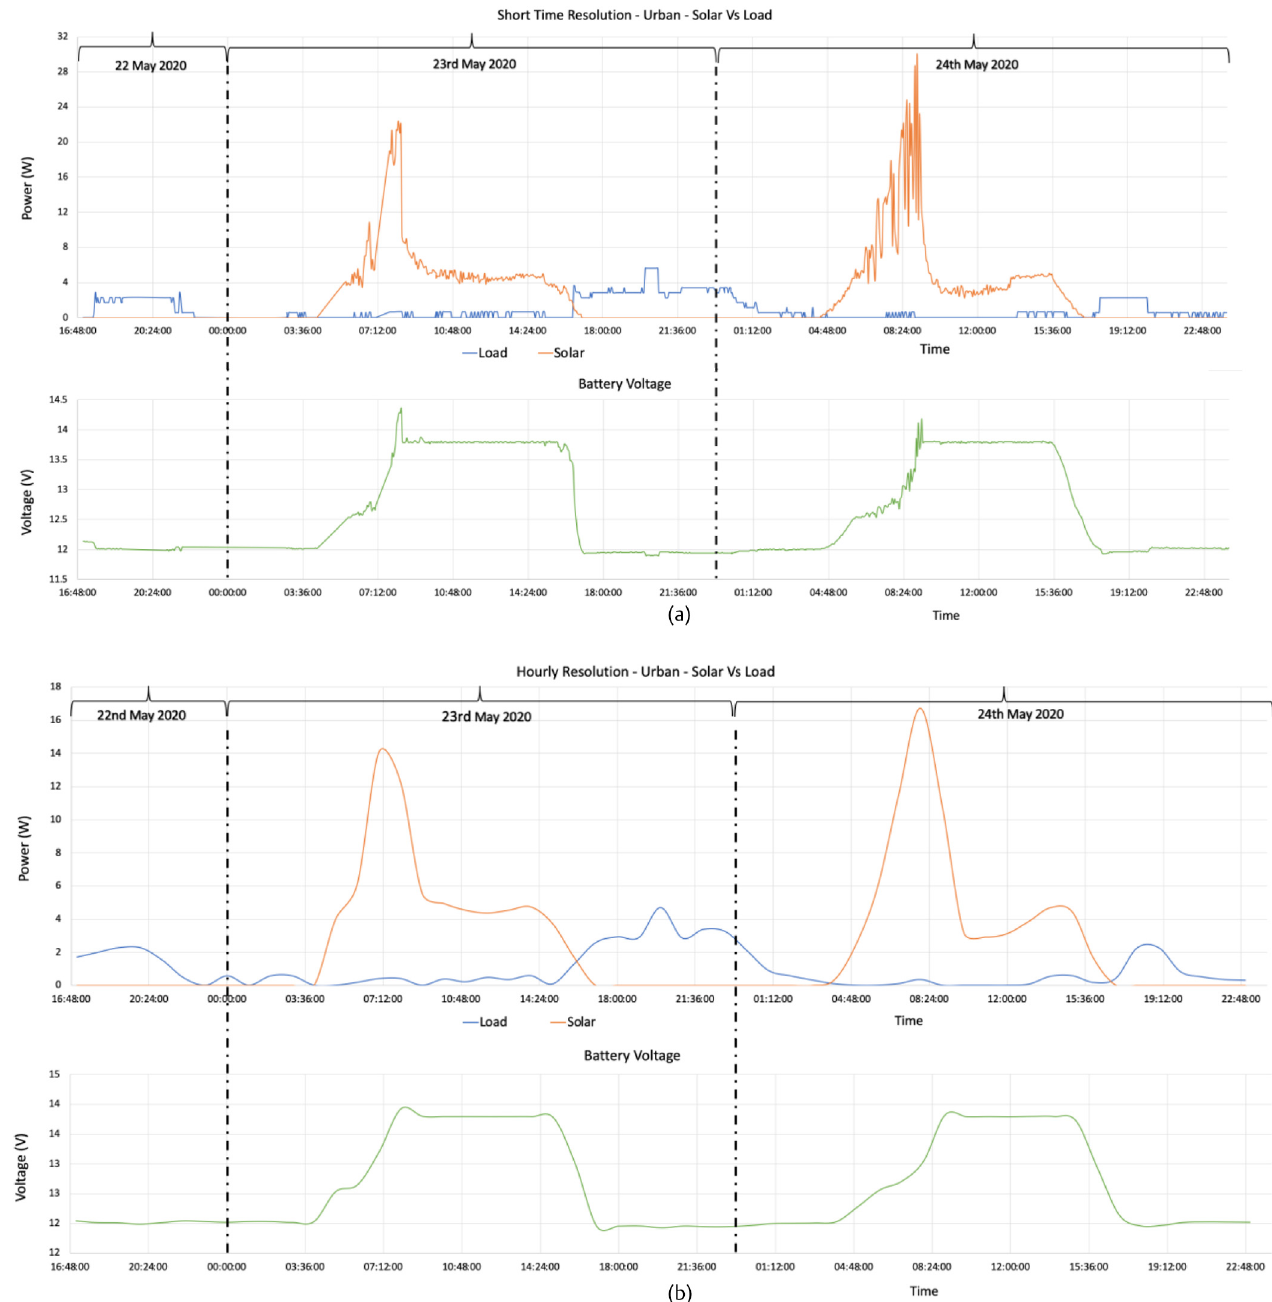
Fig. 4. Example of Daily solar data for 22nd May, 23rd May and 24th May at the Urban location. (a) For short time resolution (5-minute); (b) For hourly